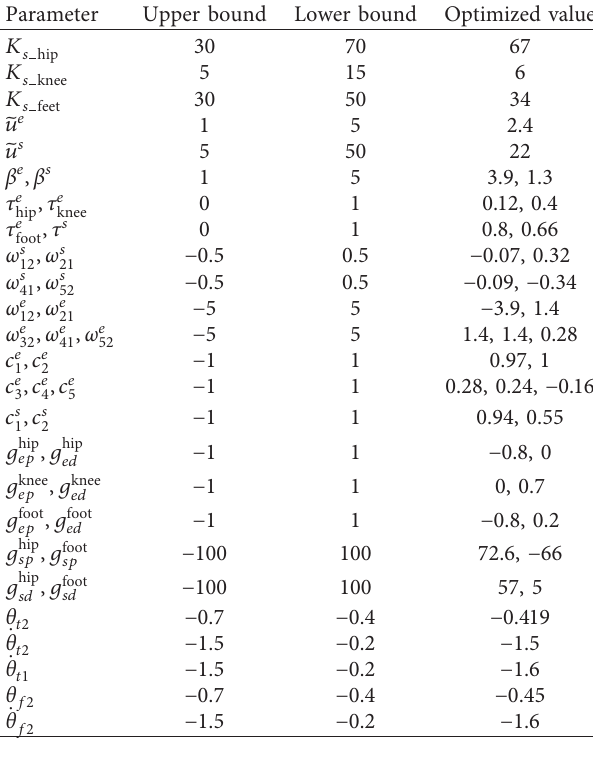
Table 1: Neural model parameters, bounds of the PSO algorithm, and the resulted optimized values.